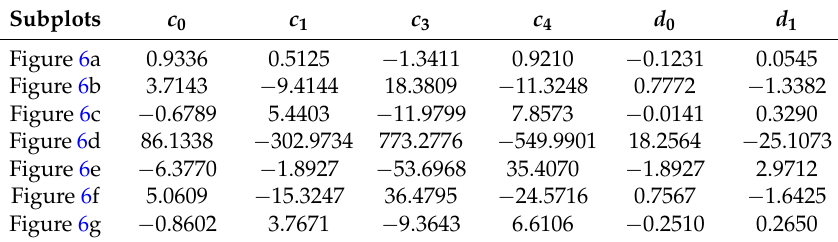
Table 7. Parametric equation coefficients of the dashed lines in Figure